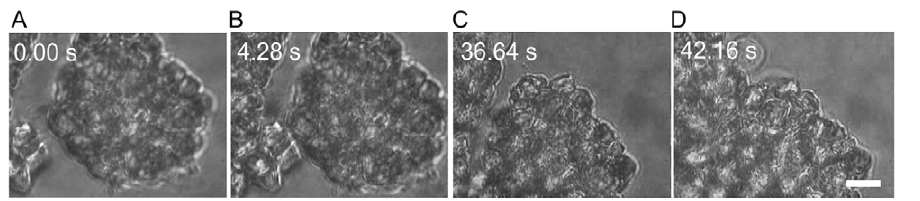
Figure 10. Time lapse images from a real-time movie (Movie S5) showing adhesion and subsequent fusion of two neurospheres. A) – C) Adhesion occurs when the two neurospheres are brought into close proximity by the optical trap for approximately 5 seconds. D) The two neurospheres fuse completely after about 40 seconds. The scale bar denotes 10 m m.